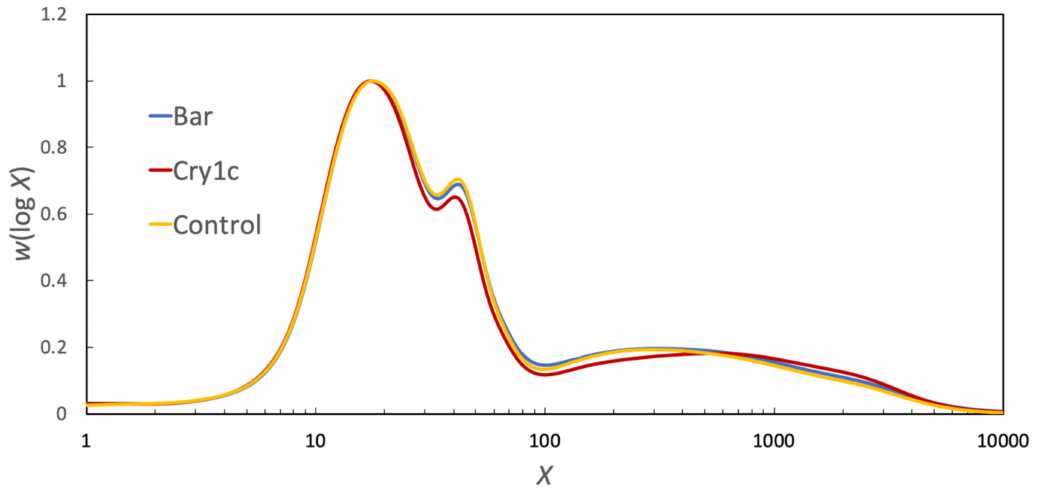
Figure 1. SEC weight distributions, w (log X ), as functions of degree of polymerization ( X ) for debranched endosperm starch from di ff erent maize lines, normalized to the maximum height. Regions i , ii , an d iii are shown in the